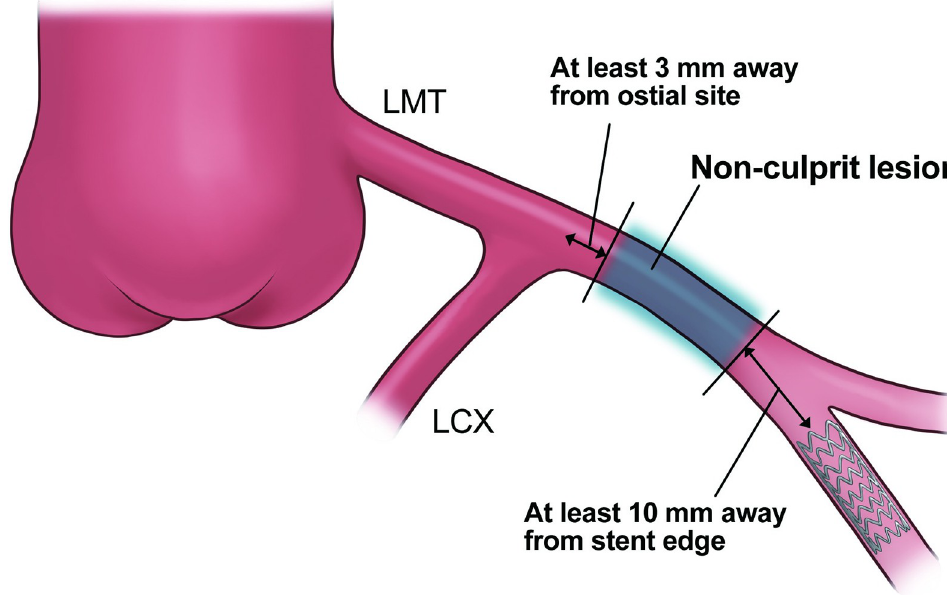
Fig 2. Description of quantitative assessment by